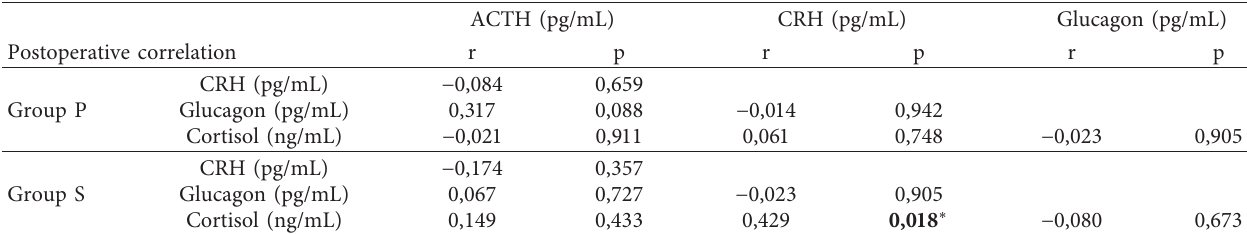
Table 5: Postoperative correlation analysis of blood variables between